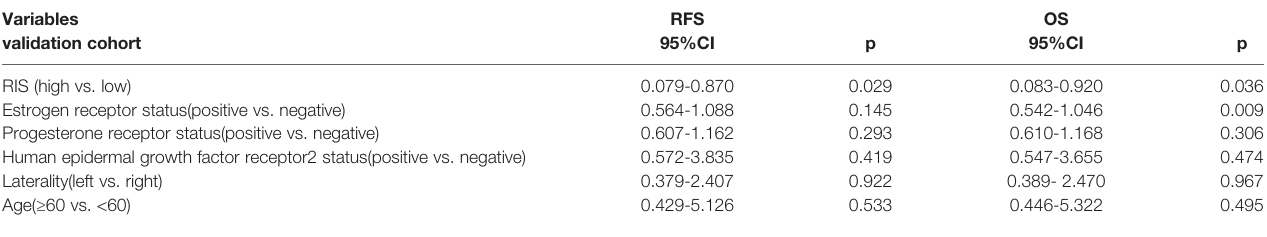
TABLE 2 | Cox regression analysis of multivariate for RFS and OS of breast cancer patients. Variables